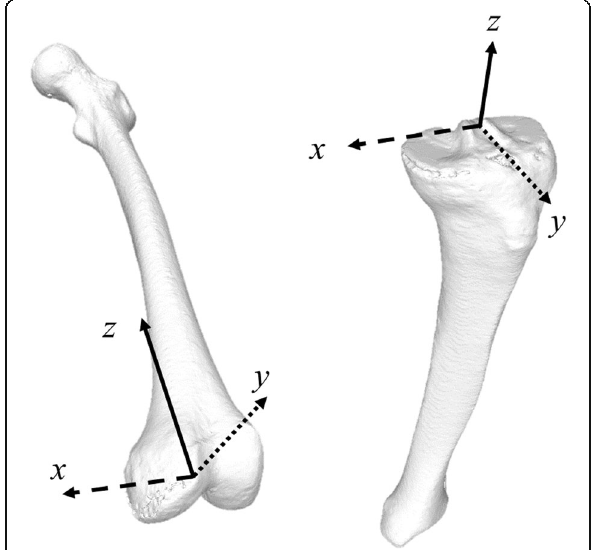
Fig. 1 Schematic illustration of femoral and tibial coordinate